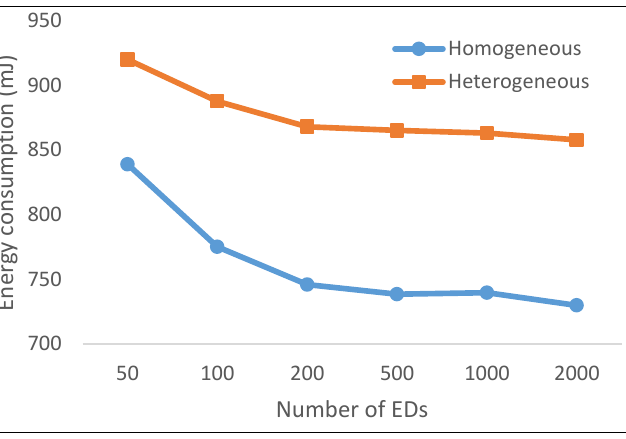
Figure 8: Energy consumption with varying number of Eds.